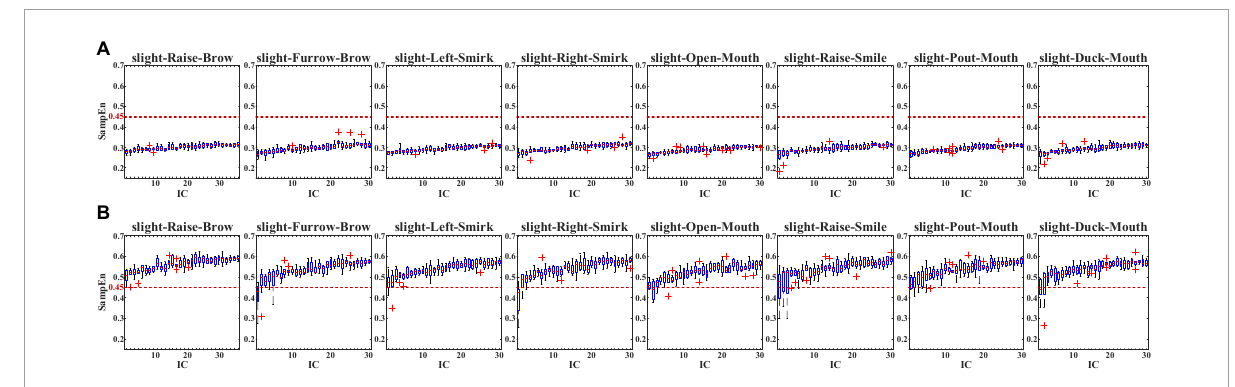
FIGURE10 The SampEn of in-control (ICs) separated from slight-facial expression (sFEs)- electroencephalograms (EEGs) with (A) passband (5 Hz, 50 Hz) and (B) passband (5 Hz, 95 Hz). The red dash line represents the 0.45 threshold.